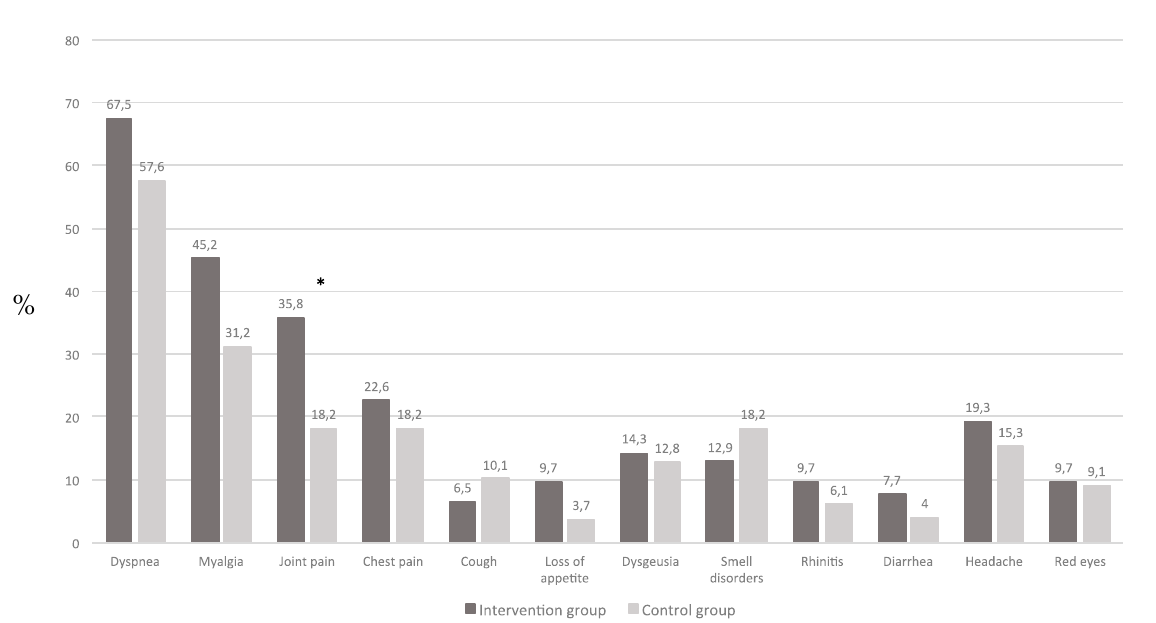
Figure 1. Prevalence of related COVID-19 symptoms at the time of baseline visit according to treatment (* p = 0.01). Table 3. Unadjusted and adjusted means of skeletal muscle index and physical performances measures (dependent variables) according to treatment after 8 weeks of